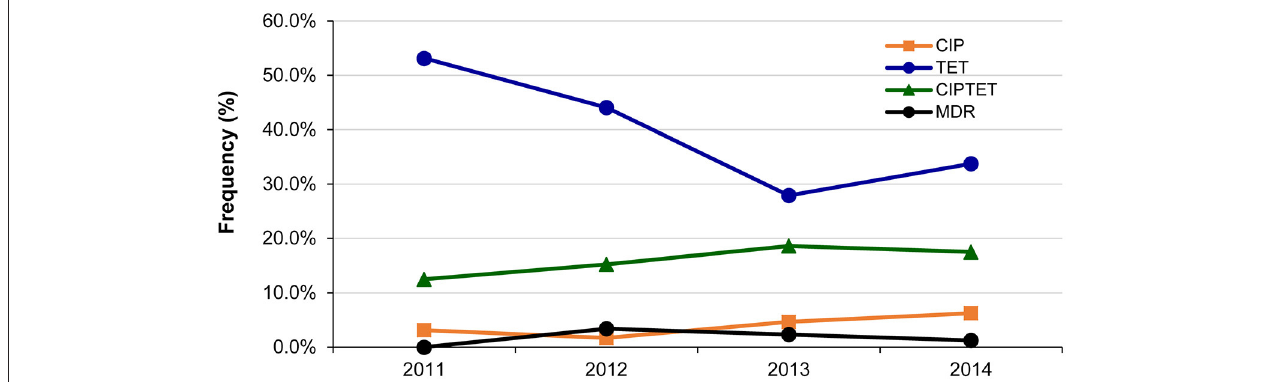
FIGURE 2 | Changes in the frequency of the most common antibiotic resistance phenotypes among 214 Campylobacter jejuni isolates over a 4-year period in Michigan. CIP, ciprofloxacin; TET, tetracycline. Multidrug resistant (MDR) isolates were resistant to CIPAZIERYCLITEL, CIPTETCLI, and CIPTETTEL.